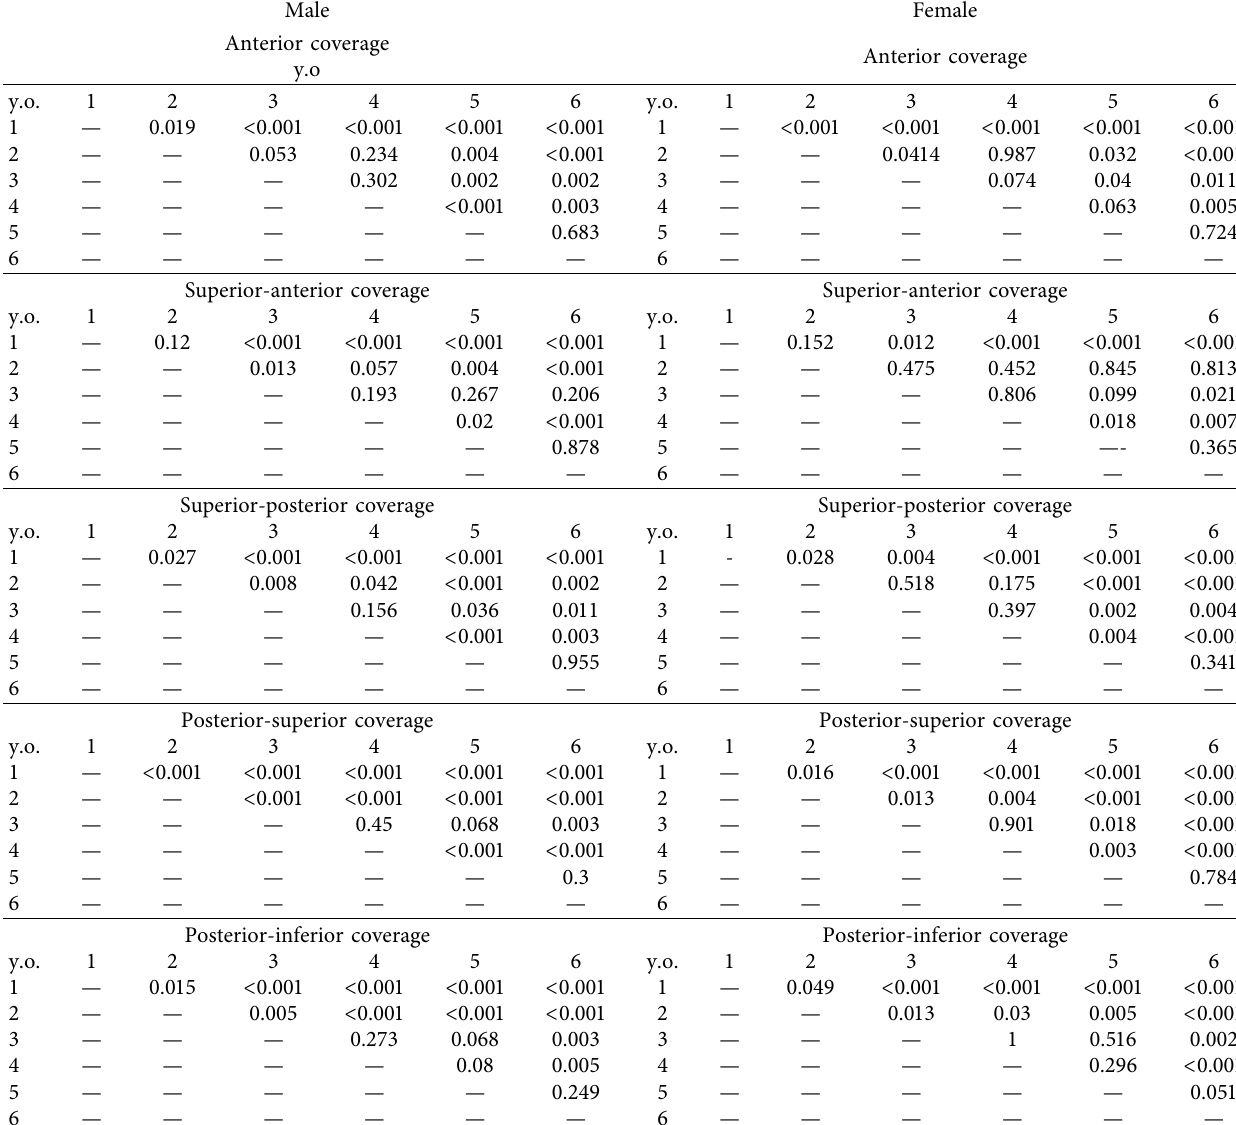
Table 2: The comparison of FH coverage by different acetabular regions in children according to age and sex. Male Anterior coverage